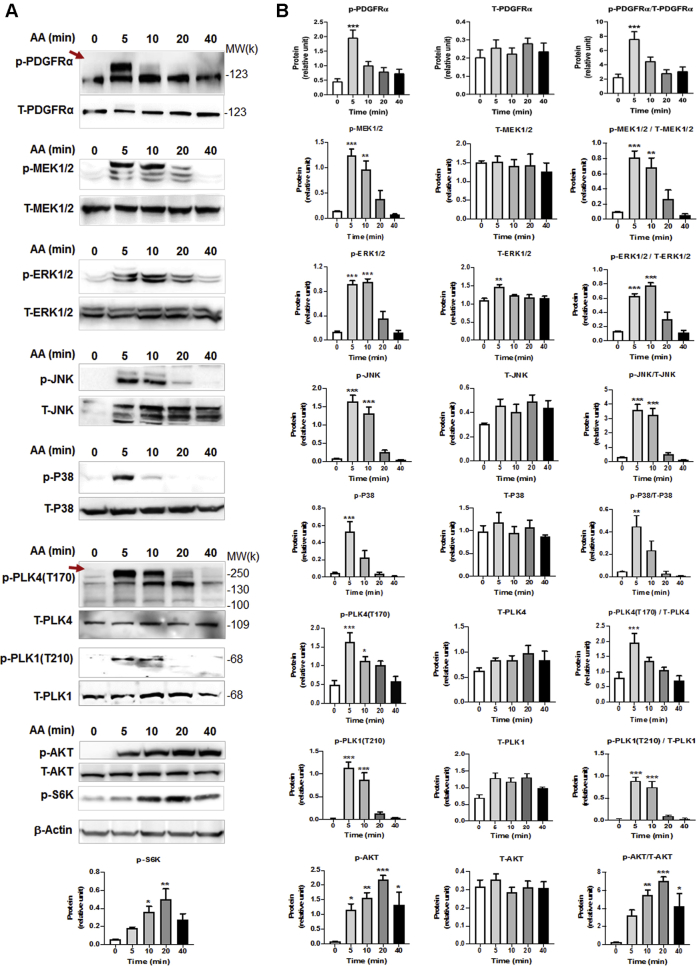
AA Stimulates Rapid PDGFRα and PLK4 PhosphorylationRat primary adventitial fibroblasts were cultured, starved, and pretreated with vehicle (DMSO) or an inhibitor, as described in Figure 1. The arrow points to phospho-protein bands. (A) Representative Western blots showing the time course of AA-induced phosphorylation of kinases. Western blots detect a phospho-protein (p-) and its respective total protein (T-). (B) Quantification: mean ± SEM, n ≥3 experiments. One-way ANOVA/Bonferroni test: ∗p < 0.05; ∗∗p < 0.01; ∗∗∗p < 0.001 compared with the 0-min control; p-S6K was included as a downstream effector of the AKT pathway. PDGFR = platelet-derived growth factor receptor; other abbreviations as in Figure 1.